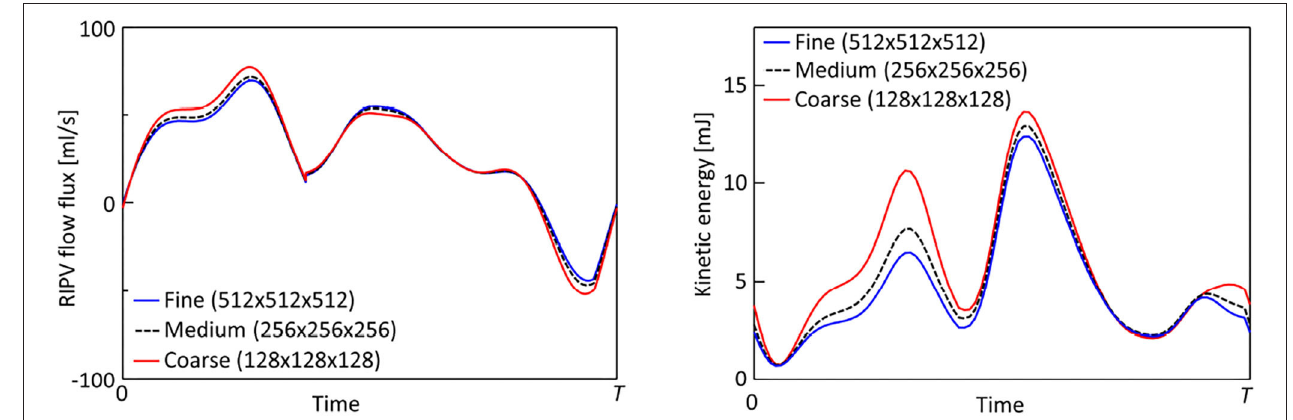
FIGURE A1 | Representative time courses of the flow rate through the right inferior pulmonary vein (left) and flow kinetic energy throughout the computational domain (right) for fine (512 × 512 × 512, grid size = 0.3 mm), medium-resolution (256 × 256 × 256, grid size = 0.6 mm), and coarse (128 × 128 × 128, grid size = 1.2 mm) grids.